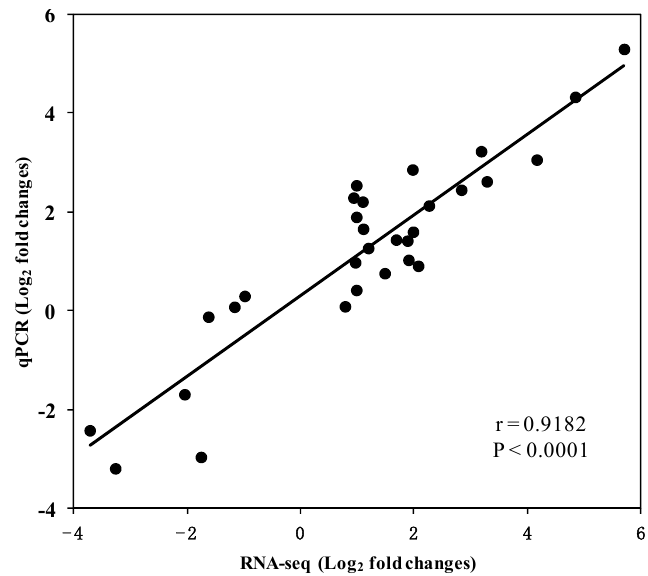
Figure 4. Correlation between RNA-seq and qRT-PCR for the selected ten unigenes. Each point represents a fold change value of expression level in OpN, LN or ON compared with CK in shoots or roots.